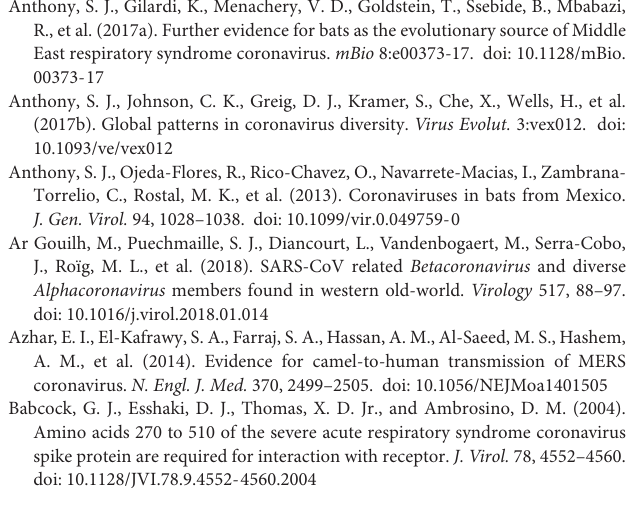
Supplementary Figure 4 | Distribution of Merbecoviruses RdRp protein sequences. The alignment of the translated full RdRp genes was performed with MUSCLE from the SeaView package (Gouy et al., 2010). The tree was built using the maximum likelihood method under the LG model with 500 repeats. The